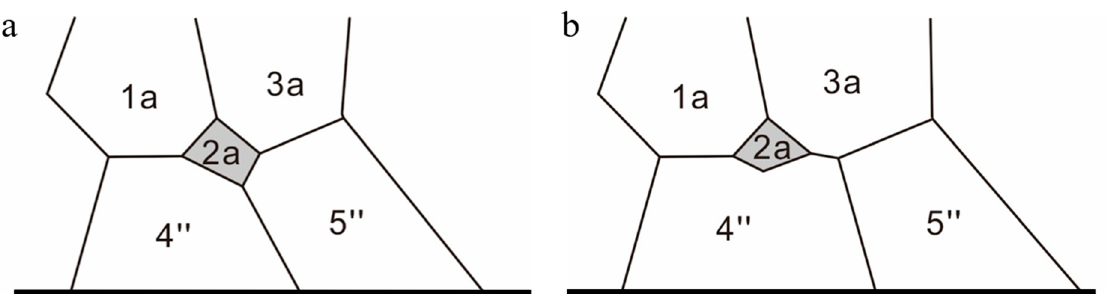
Figure 6. Schematic drawings of the intercalary plates and two location types of the fifth precingular plate (5 ʹʹ ) of Scrippsi- ella precaria : ( a ) 5 ʹʹ plate that contacted the 2a plate and ( b ) 5 ʹʹ plate that did not contact the 2a plate.